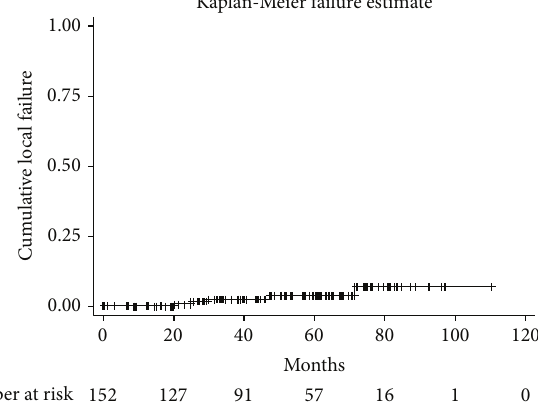
Figure 3: Kaplan-Meier cumulative local failure estimate.